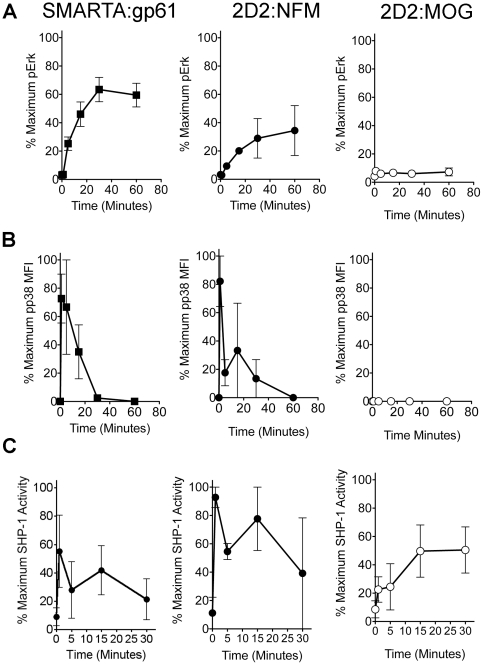
2D2 T cells stimulated with MOG have an altered signaling program.(A) Splenocytes from SMARTA or 2D2 mice were stimulated with 10 µM of the indicated antigen and the percent of maximal Erk phosphorylation was assessed at various time points by flow cytometry (gated on CD4+ cells). (B) Splenocytes from SMARTA or 2D2 mice were stimulated with 10 µM of the indicated antigen and the percent of maximal p38 MAPK phosphorylation was assessed at various time points by flow cytometry (gated on CD4+ cells). (C) Splenocytes from SMARTA or 2D2 mice were stimulated with 10 µM of the indicated antigen and SHP-1 phosphatase activity was assessed at various time points using a colorimetric assay for free phosphate with a phosphorylated peptide substrate specific for SHP-1. The percent of maximal response was assessed to highlight the kinetics of the signaling response and was calculated using GraphPad Prism/ All experiments were repeated at least three times.